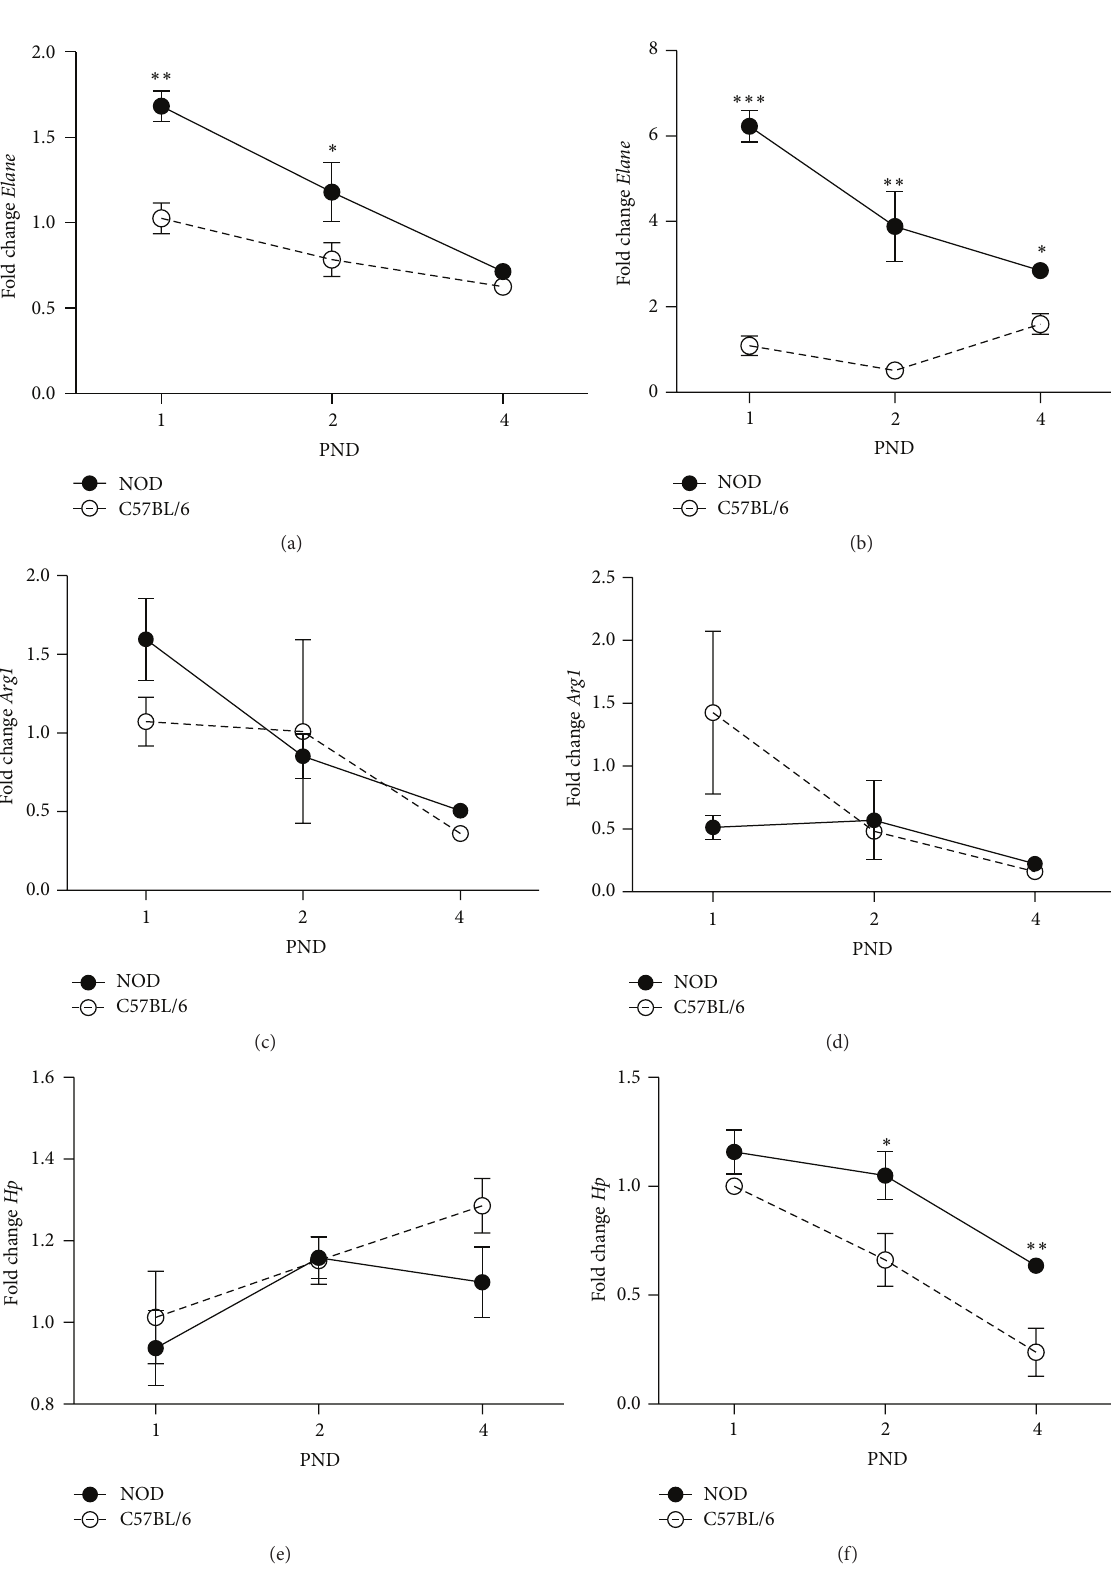
Figure 4: Relative gene expression of genes expressed in differentiation of myeloid cells in liver and spleen at PND 1, 2, and 4 of NOD and C57BL/6 mice. Data were normalized to Actb and then to C57BL/6 PND 1, which were defined as value 1. All samples were quantified in triplicate. All groups were included in a 2-way ANOVA. ∗∗∗ 𝑝 < 0.001 , 𝑝 < 0.05. (a) Expression of Elane encoding elastase in liver. (b) Expression of Elane encoding elastase in spleen. (c) Expression of Arg1 encoding arginase in liver. (d) Expression of Arg1 encoding arginase in spleen. (e) Expression of Hp encoding haptoglobin in liver. (f) Expression of Hp encoding haptoglobin in